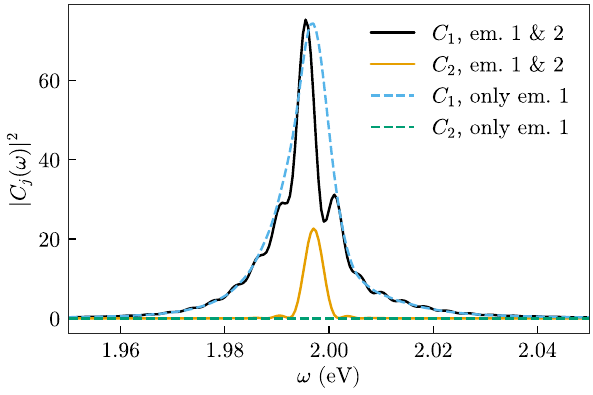
( ω ) C ( ω ) 〉 ofelectromagnetic(EM)modesat Figure4: Population 〈 C † j j time t = 1000 fs in the presence of both emitters (solid black and orange lines) and in the presence of only emitter 1 (dashed blue and green lines). Gram – Schmidt orthogonalization has been used here, so that emitter 1 only couples to continuum 1 (i.e., populations for